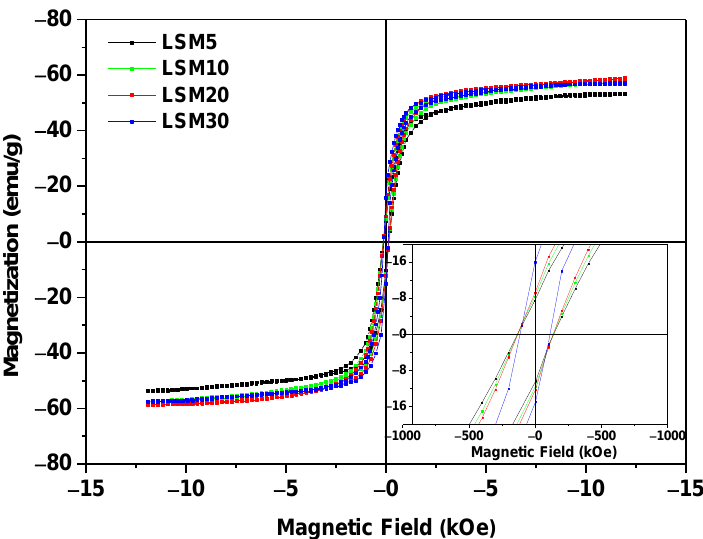
Figure 10. Magnetization of composites vs. magnetic field at 300 K normalized by mass of LSM- accuracy 10 −8 emu.